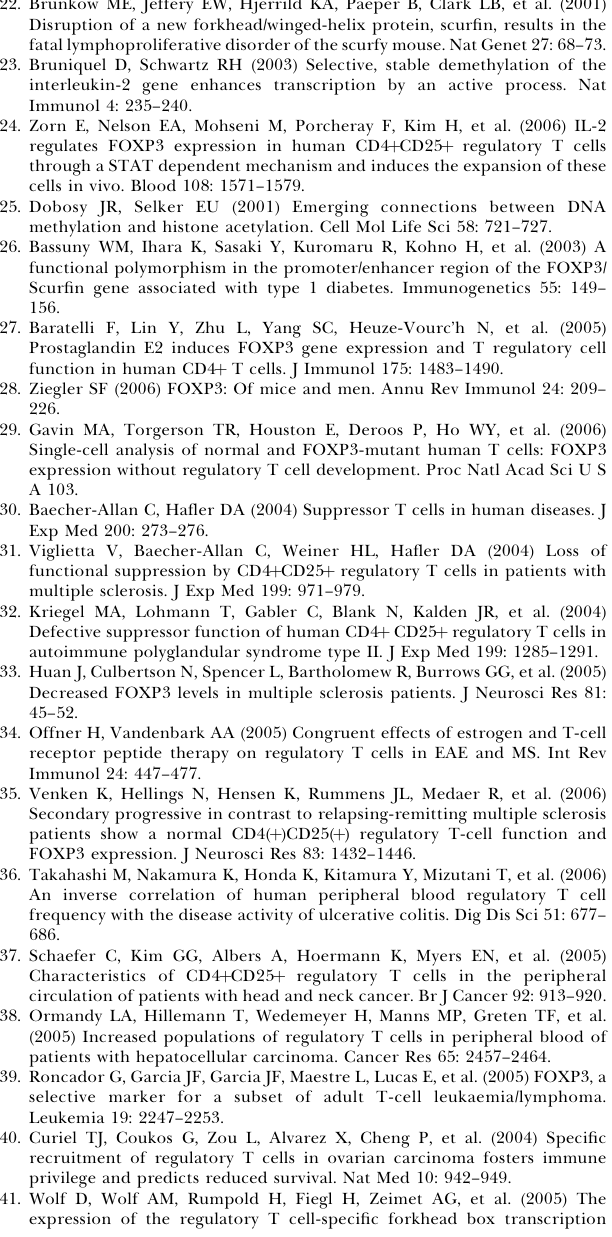
Table S1. Methylation Status of Individual CpG Motifs within the foxp3 Locus Summary of all DNA methylation analyses performed for indicated subsets. Shown is the degree of methylation (%) for individual CpG motifs. CpG motifs from amplicon 2 overlapping with motifs in amplicon 1 were excluded. n.a., not